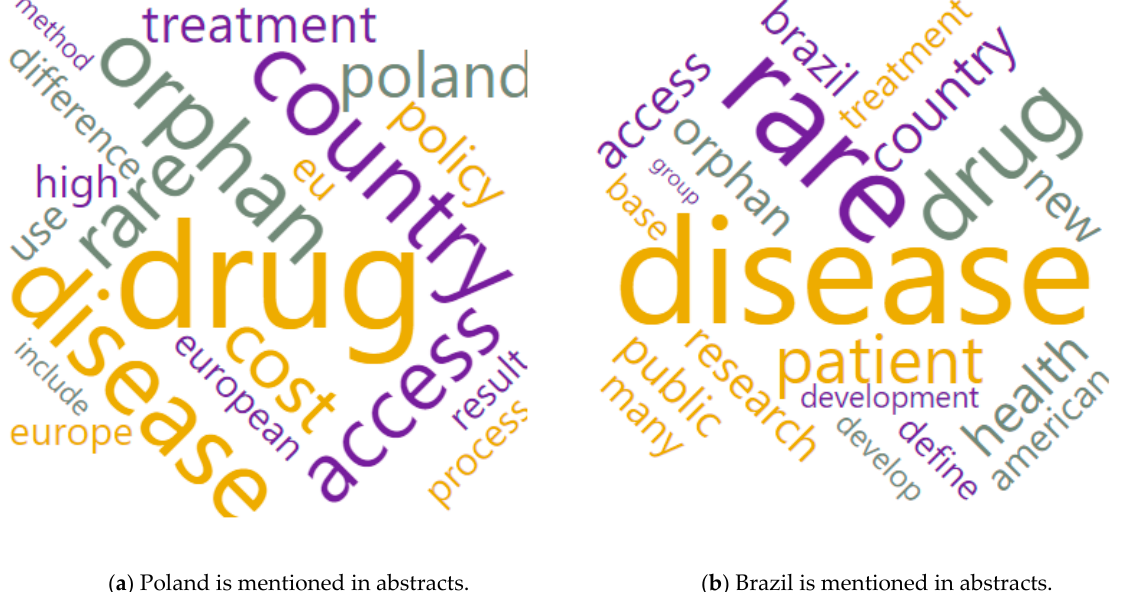
Figure 6. Word clouds of terms from abstracts connected with geographic locations.